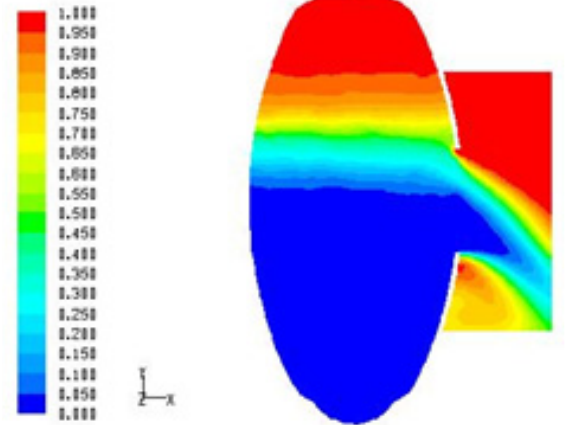
Fig. 3-3. Water level defined at the upper edge of the outlet, the flow is separated from the chamber wall, it is visible the beginning rotating flow, the air flow in the vent hole practically does not flow out.